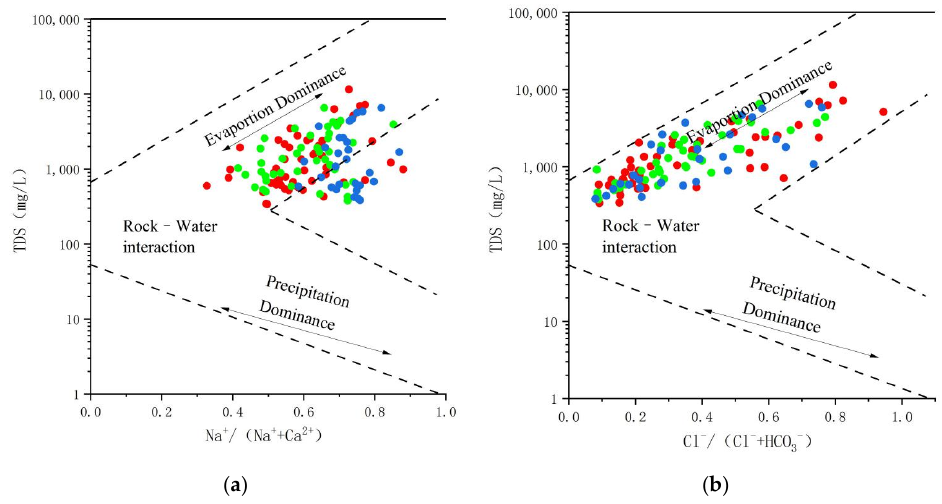
Figure 4. Gibbs diagram of groundwater samples collected from the Jinta Basin, China. ( a ): TDS versus Na + /(Na + +Ca 2+ ), ( b ): TDS versus Cl − /(Cl − +HCO 3 − ).